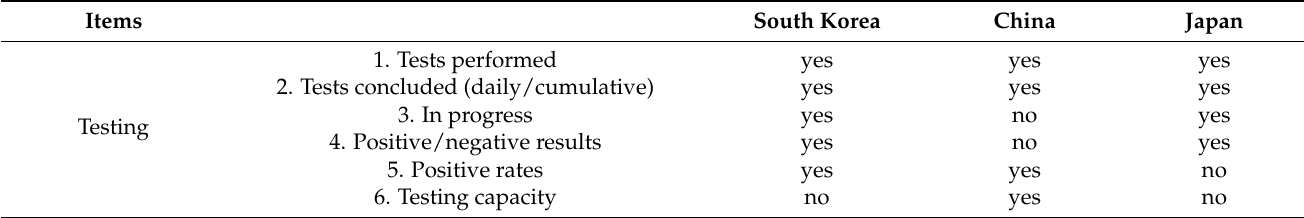
Table 3. Content comparison of “vaccines” for the COVID-19 dashboard in South Korea, China, and Japan. Items